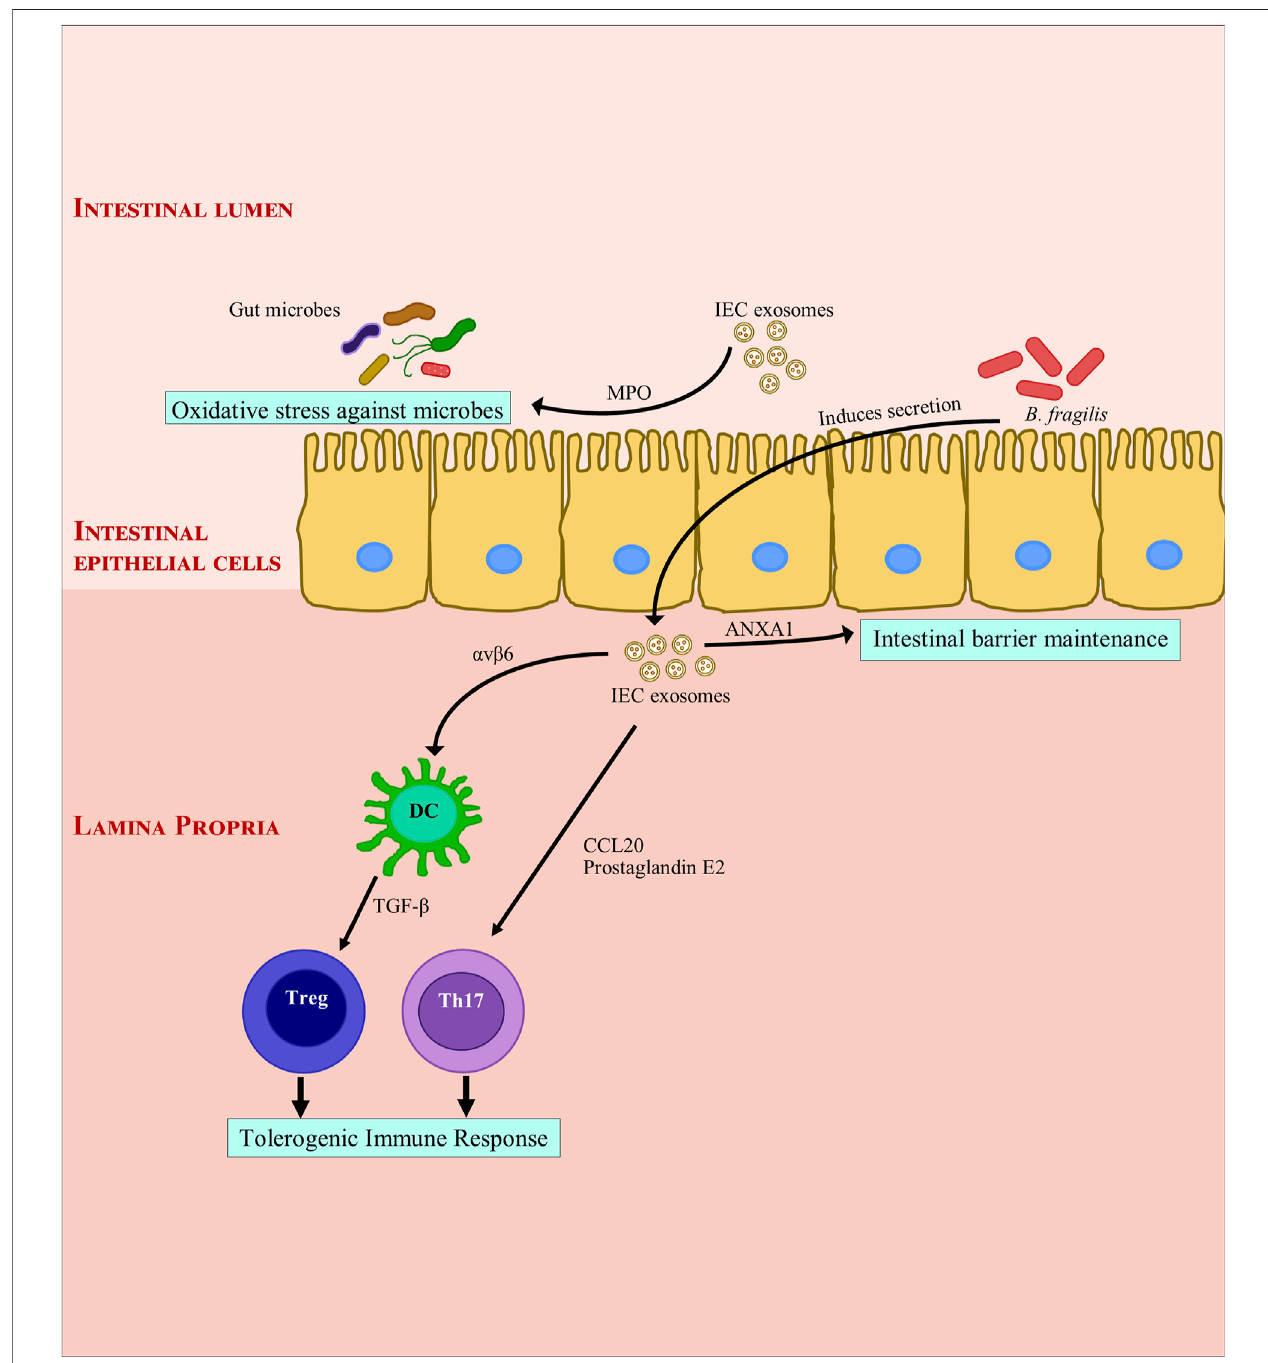
FIGURE 1 | Modulationofintestinalin fl ammationbyintestinalepithelialcellderivedexosomes.Intestinalepithelialcellderivedexosomeshelpmaintaingutimmunehomeostasis throughsecretionofAnnexinA1.Theyinduceatolerogenicimmuneresponsebysecretionofintegrin,cytokinesandchemokines.Theyalsoprotectthegutimmunebarrierfrombacterial invasion by secreting myeloperoxidase which creates oxidative stress against bacteria. ANXA1, Annexin A1; α v β 6, Integrin α v β 6; B. fragilis , Bacteroides fragilis ; CCL20, C-C Motif Chemokine Ligand 20; DC, dendritic cell; IEC, Intestinal epithelial cells; MPO: myeloperoxidase; Th17, TGF- β , transforming growth factor β ; T helper 17; Treg, regulatory T cell.